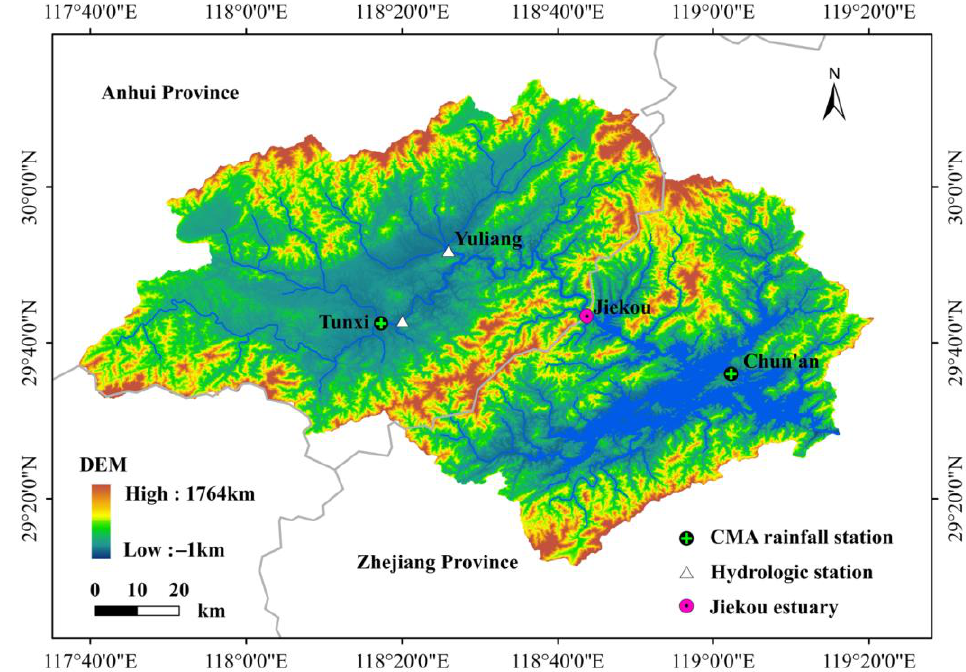
Figure 1. The location of the Xin’anjiang Reservoir Basin , China.